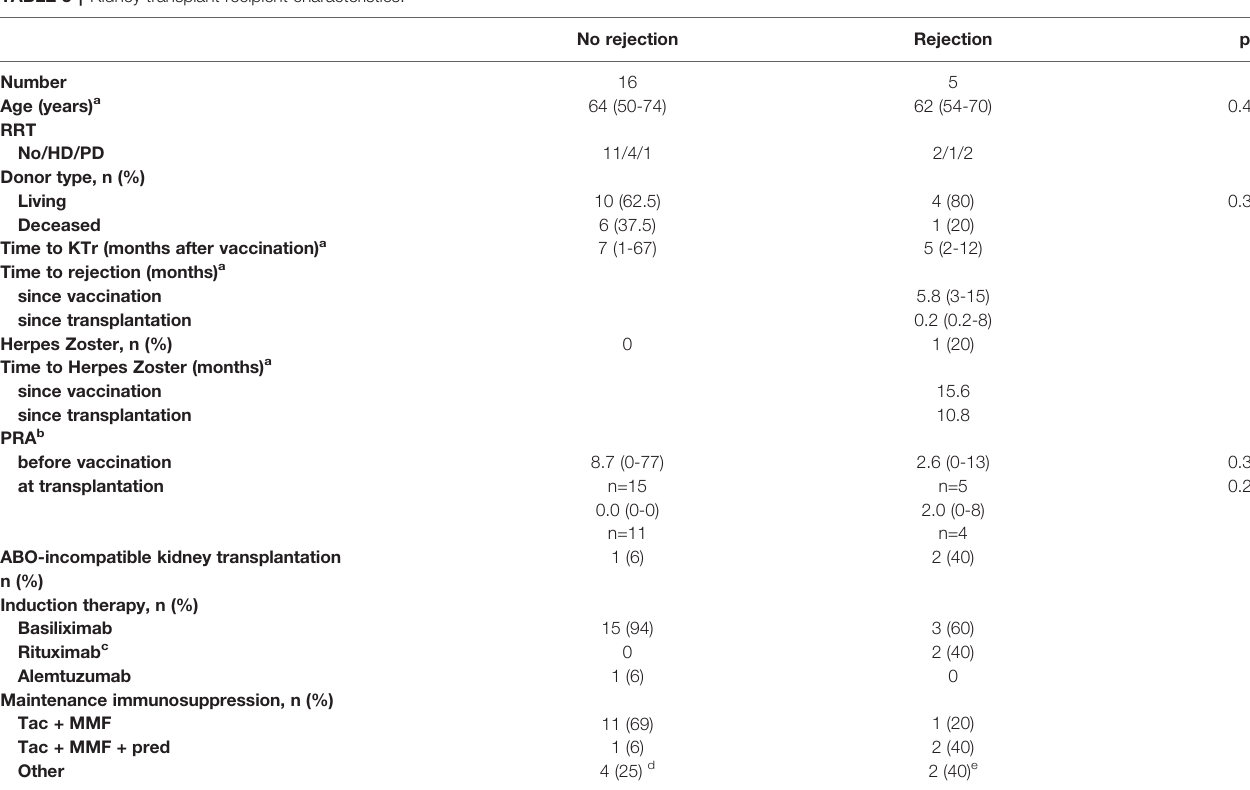
TABLE 3 | Kidney transplant recipient